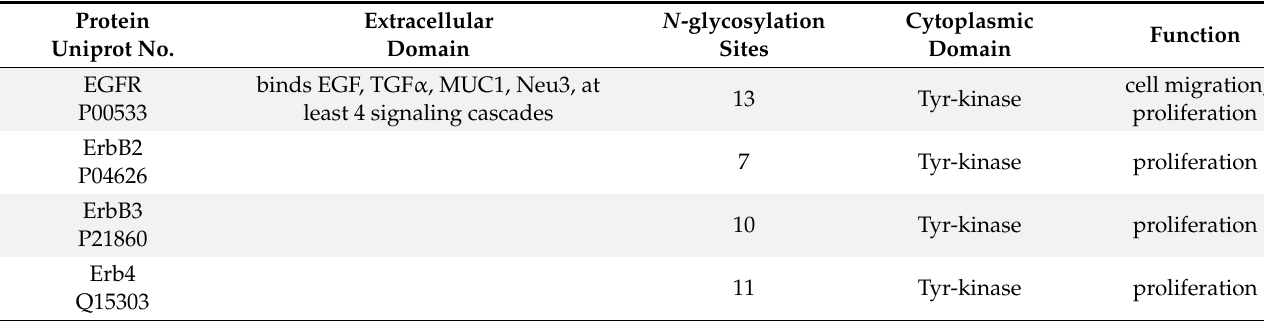
Table 1. Tyrosine kinase